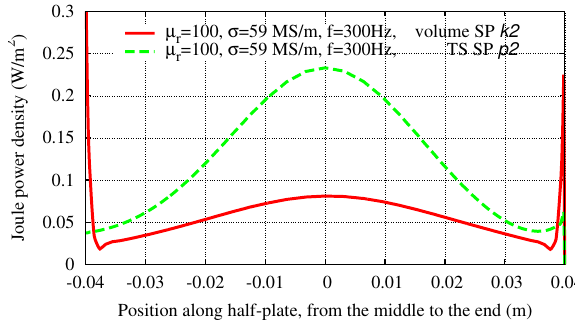
Fig. 6. Joule power loss density for SP p 2 and SP k 2 along the thin plate